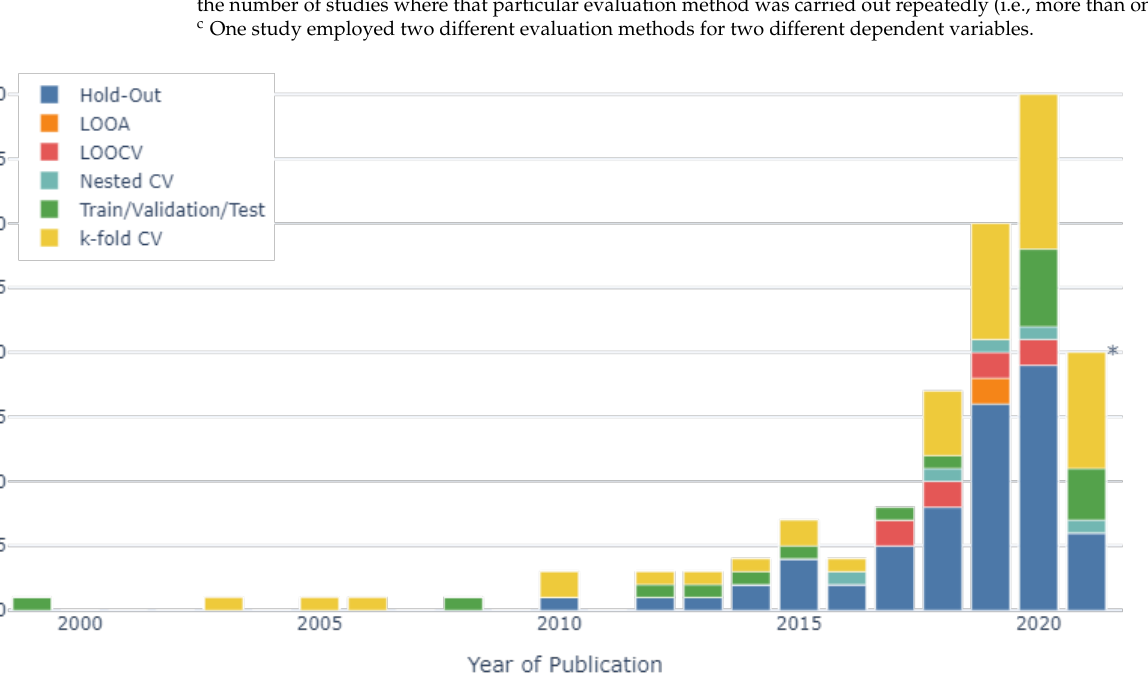
Figure 8. Number of publications per year labelled according to validation method used (n = 127). * Data collected up to June, 2021.